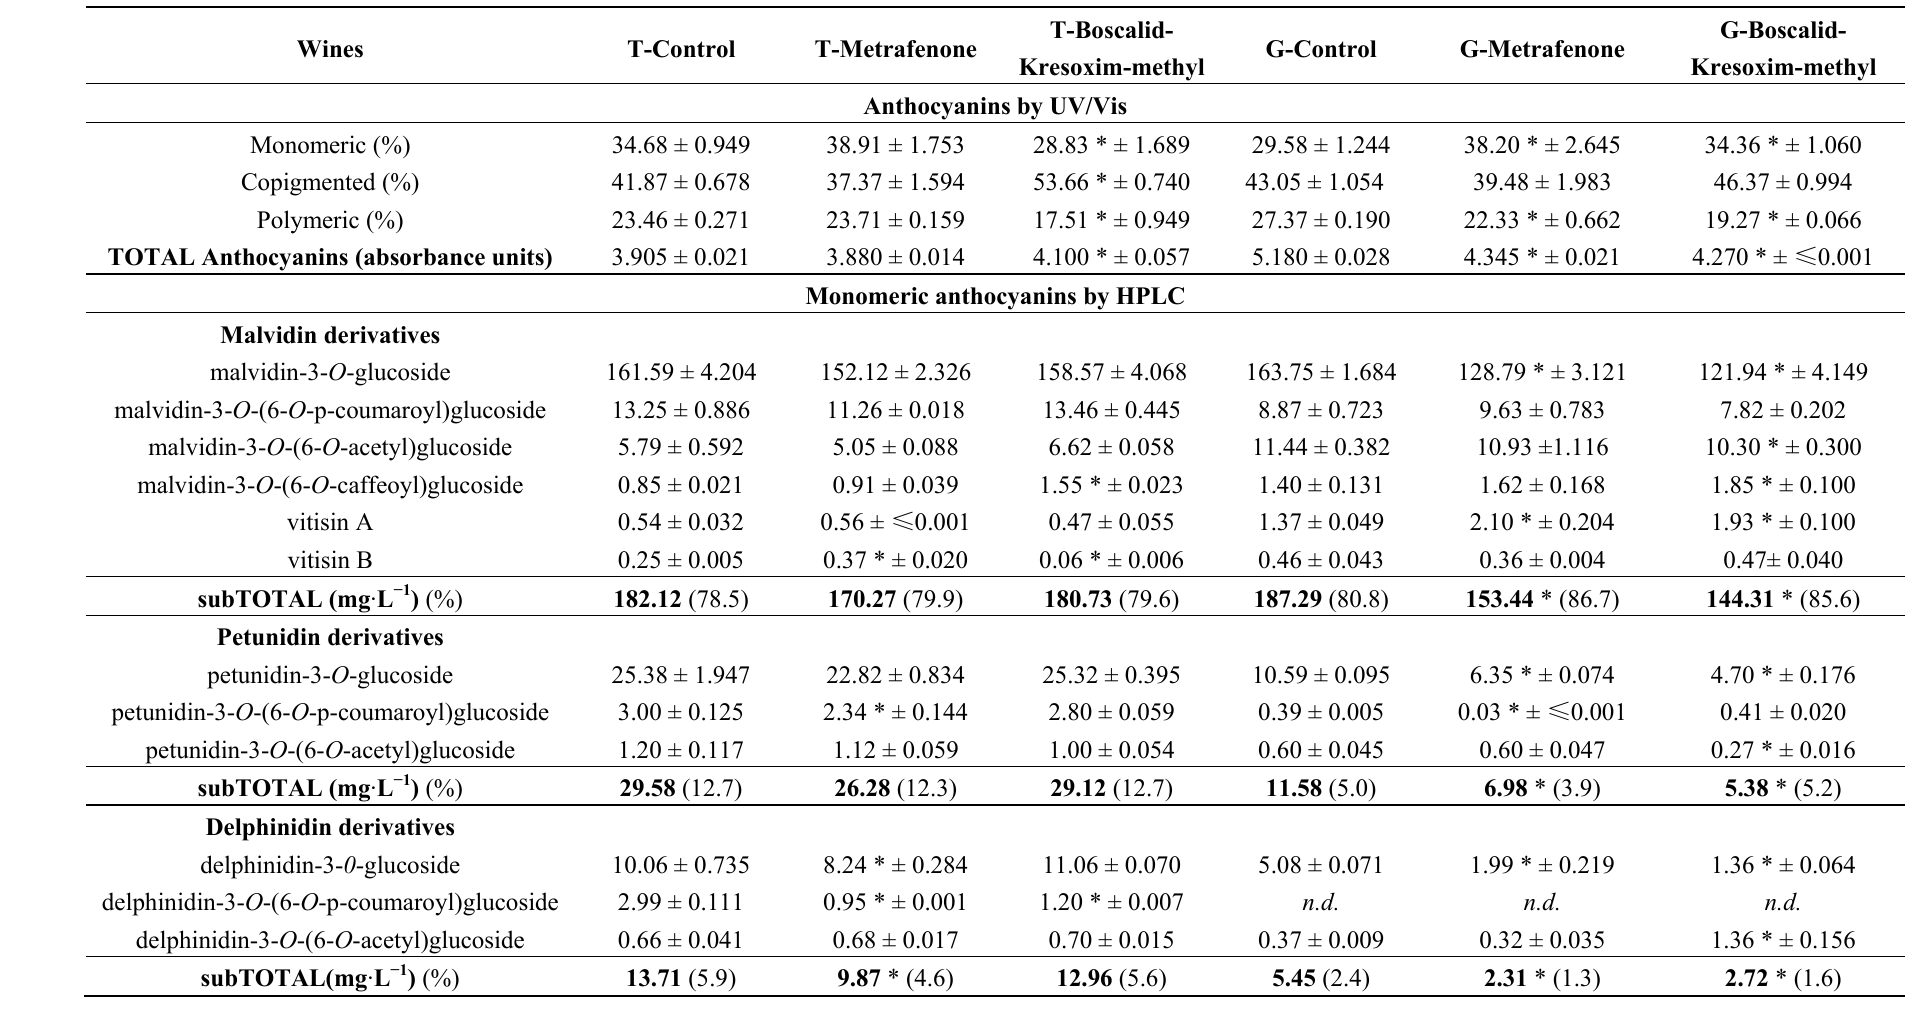
Table 1. Anthocyanin composition and quantitative data (mg·L − 1 ± SD) of monomeric anthocyanins in Tempranillo and Graciano